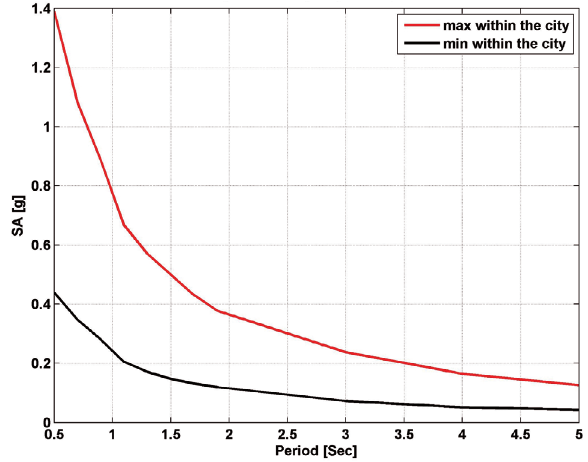
Figure 13. Estimated seismic hazard variations within the city con- sidering site effects estimated from response spectrum ratios, for 10% probability of exceedance in 50